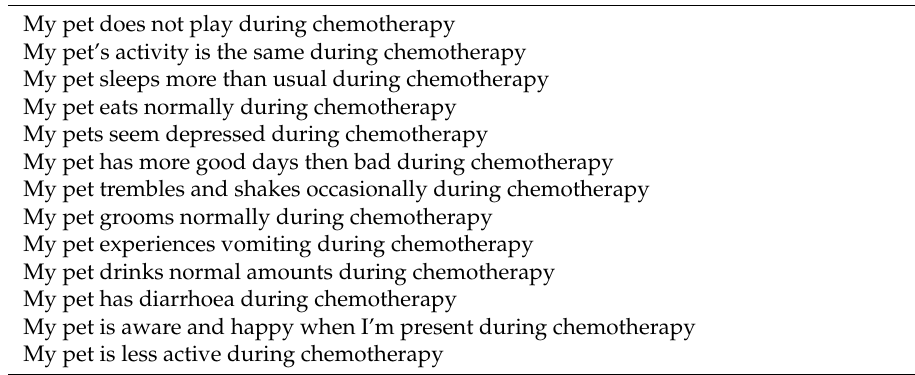
Table 1. Quality of life assessment